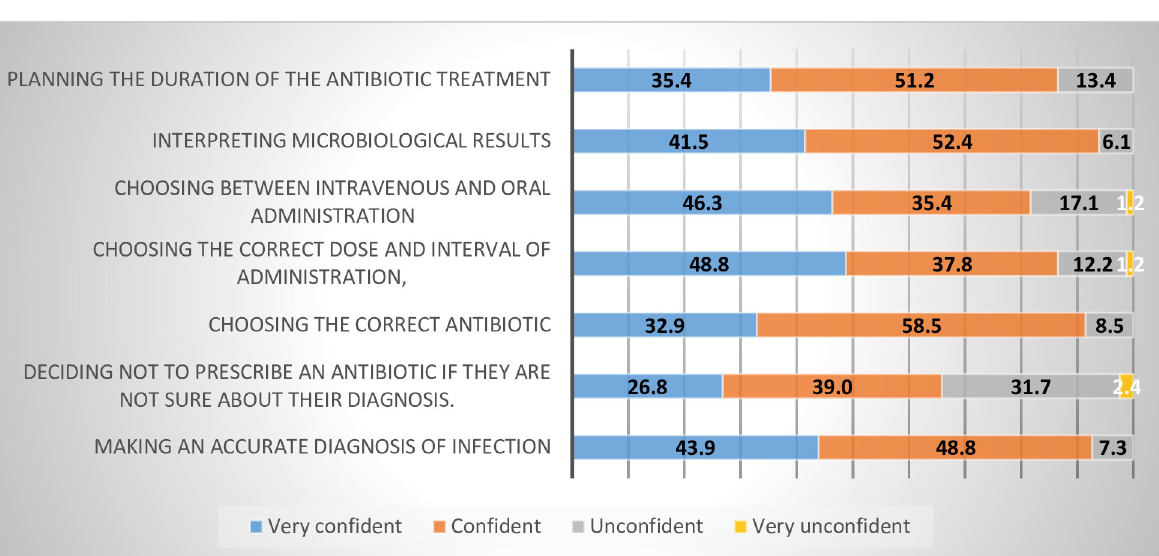
PLOS ONE | https://doi.org/10.1371/journal.pone.0273673 September 15,